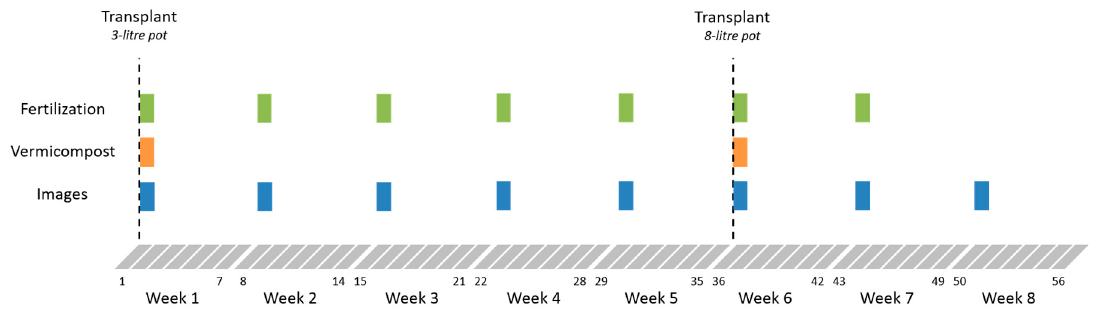
Figure 2. Chronology of plant treatment and image acquisition during the experiment.